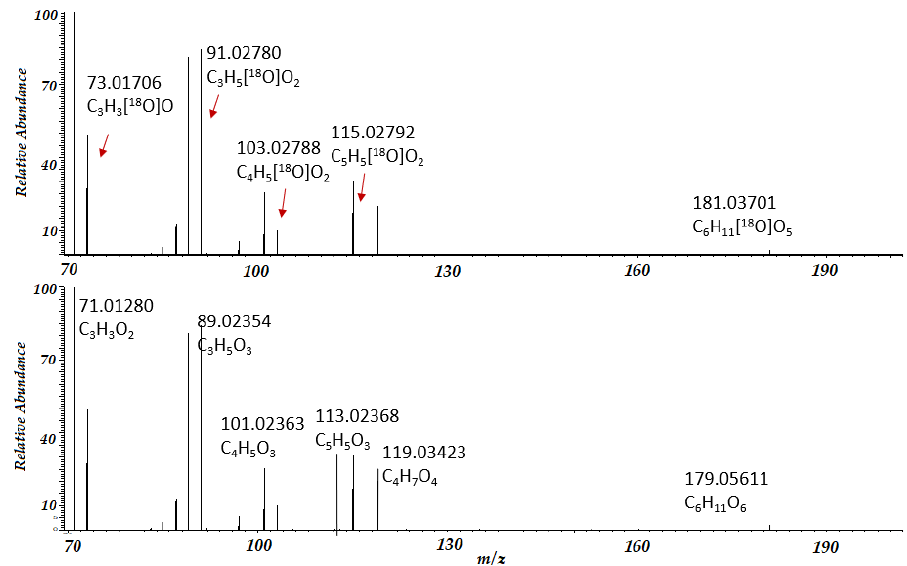
Figure 3. The CID fragmentation spectrum of D-glucose in negative ESI mode, after ( top ) and before ( bottom ) 16 O/ 18 O exchange.